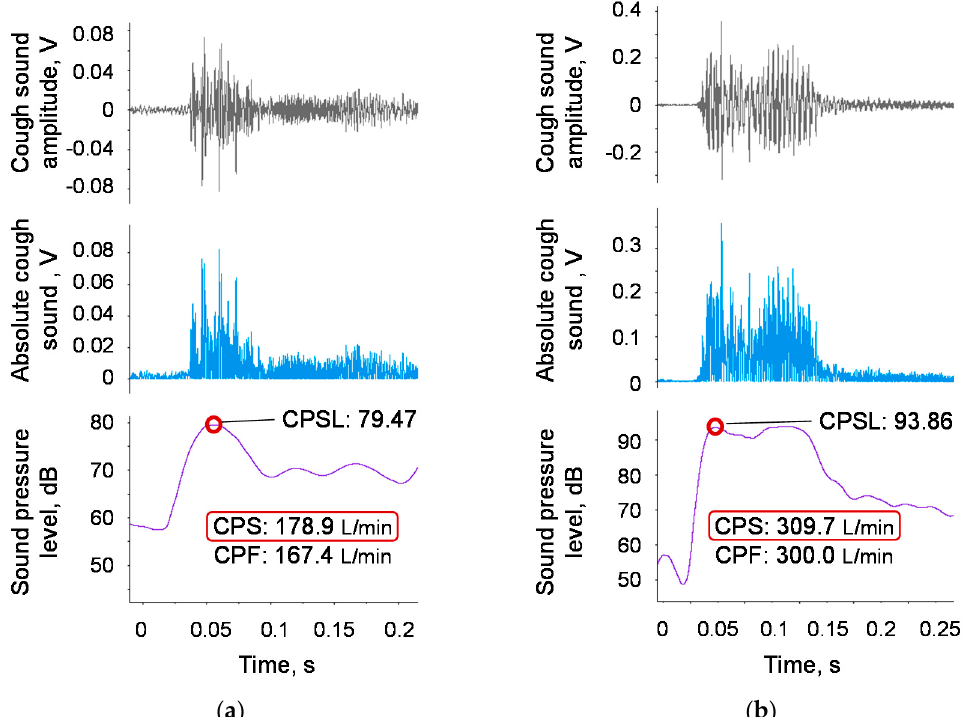
Figure 9. Examples of elderly participants. The grey line represents the measured cough sound signal. The light blue solid line represents the bandpass-filtered and rectified sound signal. The purple solid line represents the moving average with a time window of 20 ms. The red circle represents the maximum point of the moving average. ( a ) Example of a 77-year-old female with a measured CPF below the reference value of 270 L/min. The respiratory function test showed slightly low values of %VC = 83.5% and FEV 1 /FVC = 83.0%, but these values exceed the reference value. ( b ) Example of a 70-year-old male with a measured CPF above the reference value of 270 L/min. The respiratory function test showed normal values of %VC = 91.6% and FEV 1 /FVC =